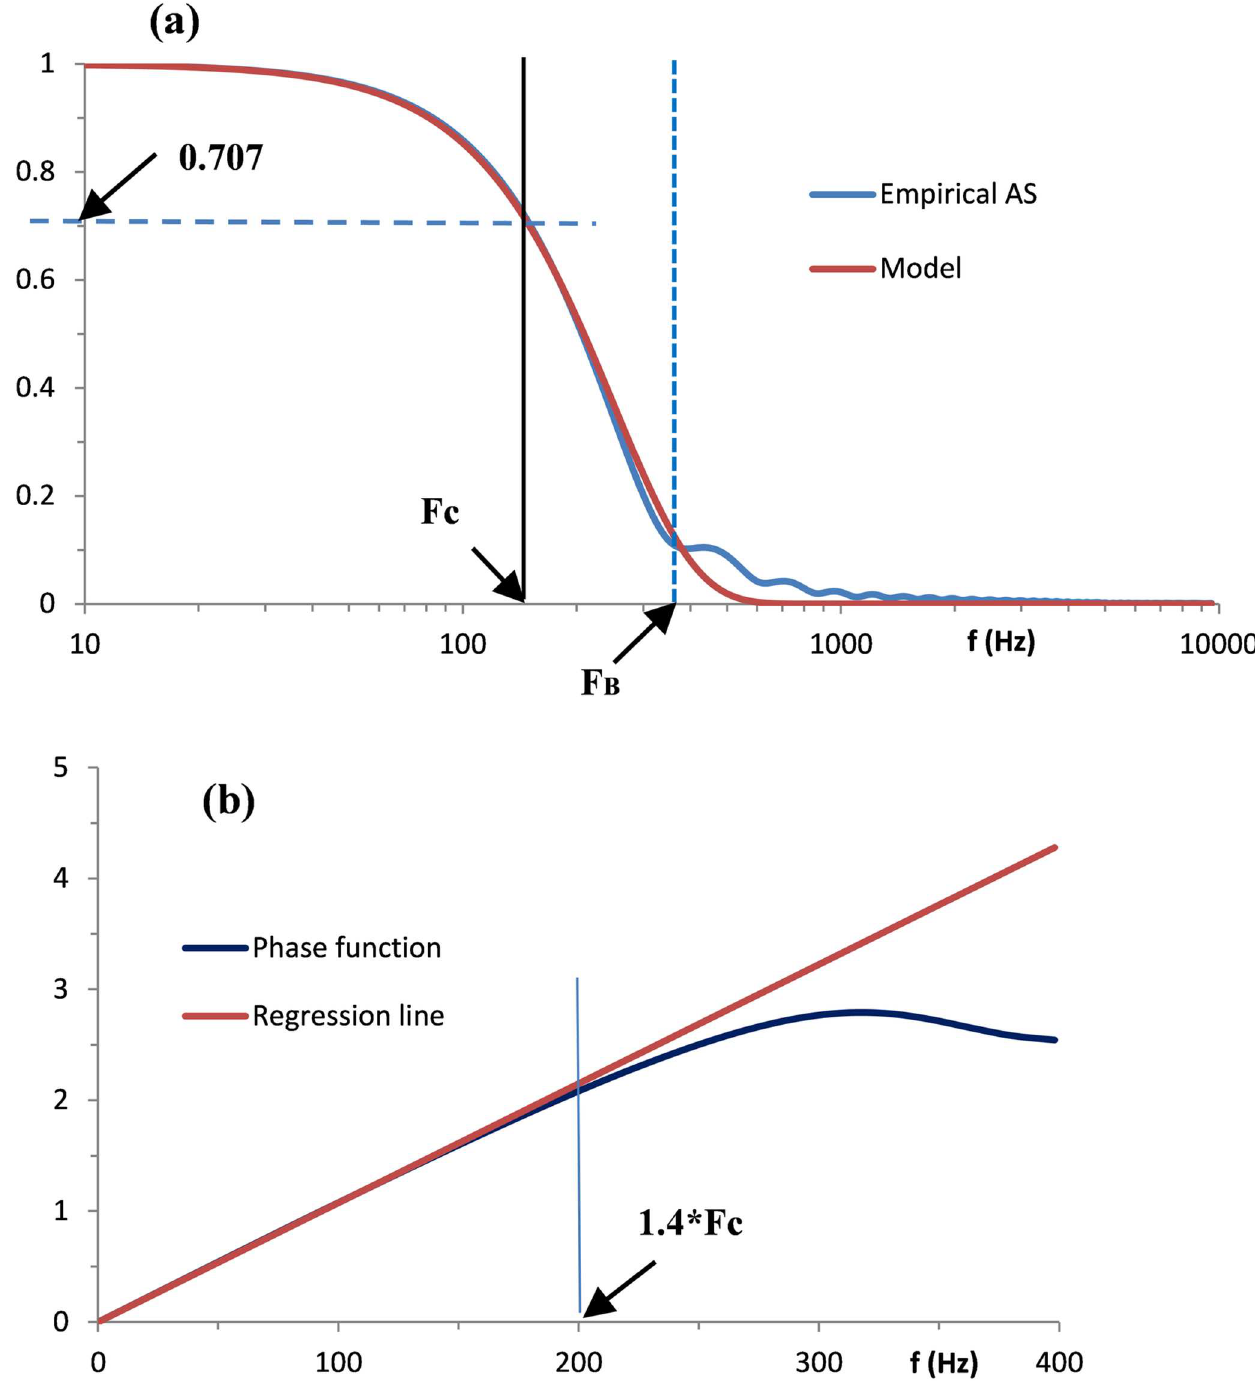
Fig 2. Empirical frequency characteristics computed by the SBF algorithm from component waveform 5 in Fig 1a and their models. (a) Amplitude spectrum and Gaussian model. The arrows show cut-off frequency F C and boundary frequency F B . The y-axis units are dimensionless. (b) Phase function and linear regression line. The arrow indicates the right boundary point of the frequency range over which the deviation of the phase function from linearity is neglected. The y-axis units are radians.